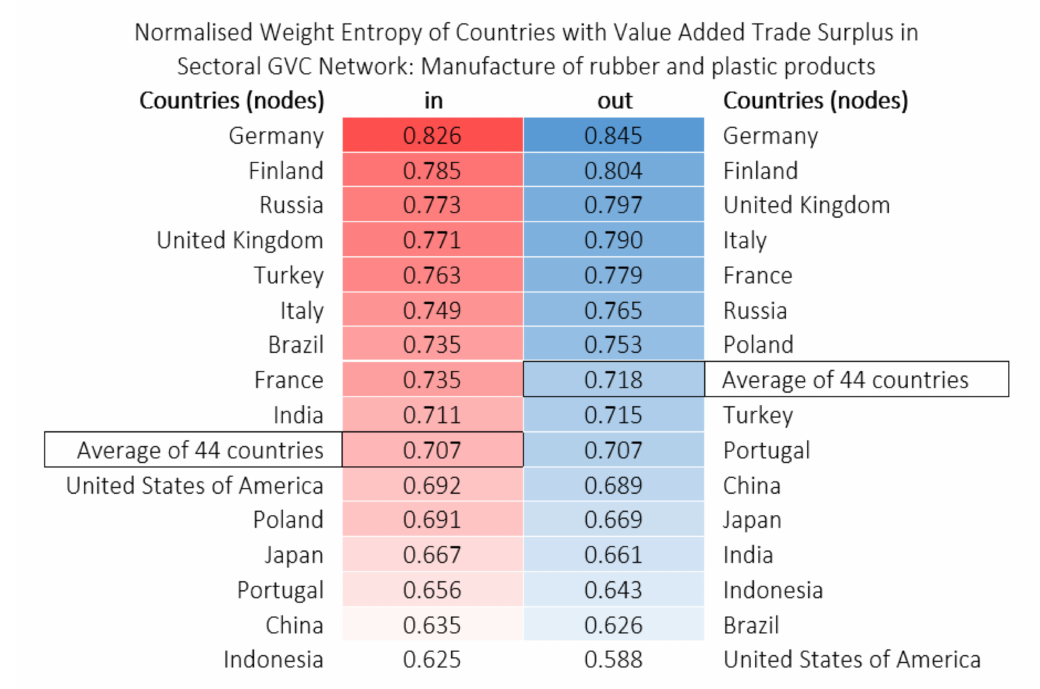
Figure 5. Sectoral GVC network: “Manufacture of chemicals and chemical products”. Normalized in- and out-weight entropy average (2000–2014) of countries with a value added trade surplus.